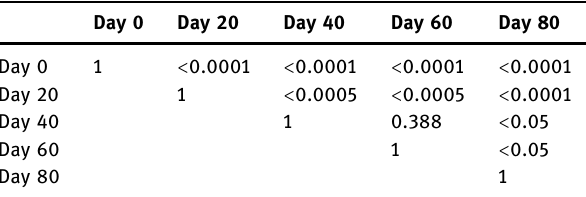
Table 3: Statistical results ( p - value ) of body weight in the fresh - water giant prawn Macrobrachium rosenbergii between 20 -